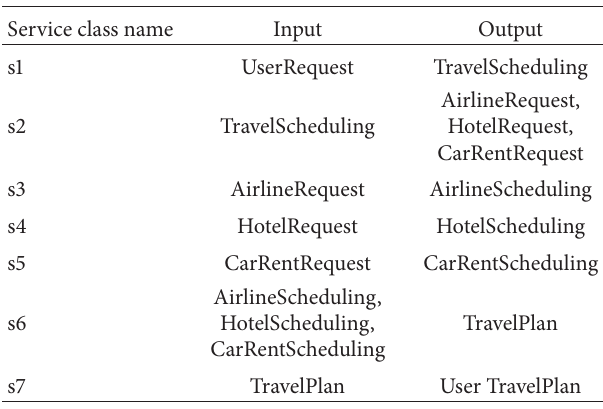
Table 1: Example.